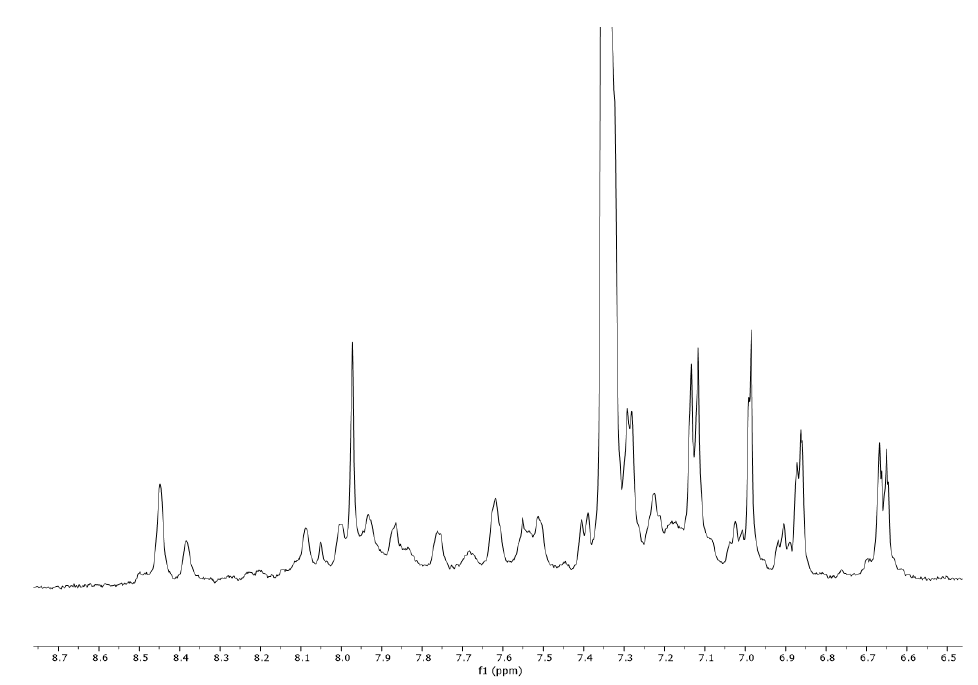
Figure 7. Expanded region A (δ = 6.5 –8.7 ppm) of a 1 H-NMR spectra (500 MHz, CD 3 OD) of Vespa velutina venom obtained by electrical stimulation.